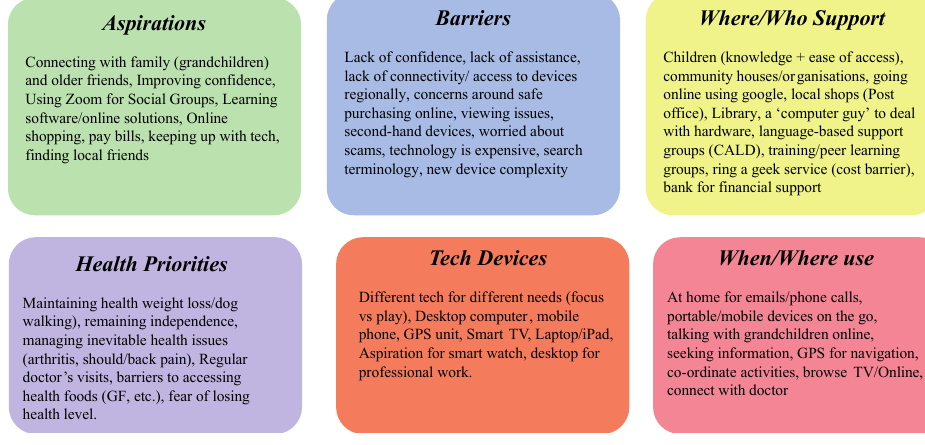
Figure 7. Medium-literacy persona.